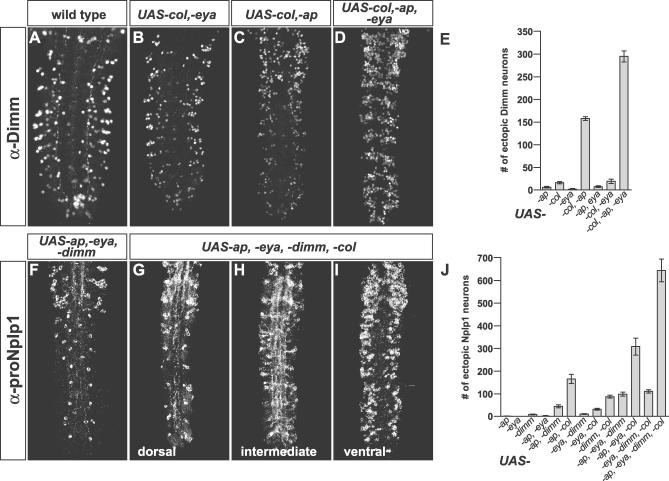

col Can Act in a Combinatorial Manner with ap and eya to Activate Dimm, and with All Three Regulators to Activate Nplp1 and DopR(A–E) Expression of Dimm in 18-h AEL VNCs. Single misexpression of each regulator has limited effect upon Dimm expression, but combinatorial expression of col/ap or col/ap/eya leads to striking ectopic Dimm expression. (E) Quantification of Dimm expression in the various misexpression experiments (n > 3 thoracic T1–T3 segments). Importantly, the addition of col to the different codes has greatly increased effect upon Dimm—compare ap/eya with col/ap/eya.(F–J) Expression of Nplp1 in 18-h AEL VNCs. Single misexpression has limited effect upon Nplp1 expression, but combinatorial expression leads to strong ectopic Nplp1 expression. (J) Quantification of Nplp1 expression (n > 3 VNCs; numbers denote total number of expressing cells per VNC). Importantly, the addition of col to the different codes has greatly increased effect also upon Nplp1—compare ap/eya/dimm with ap/eya/dimm/col.Genotypes: (A) w1118 and (B–J) elav-GAL4 crossed to single UAS-cDNA transgenes or combinations of the various UAS-cDNA transgenes.